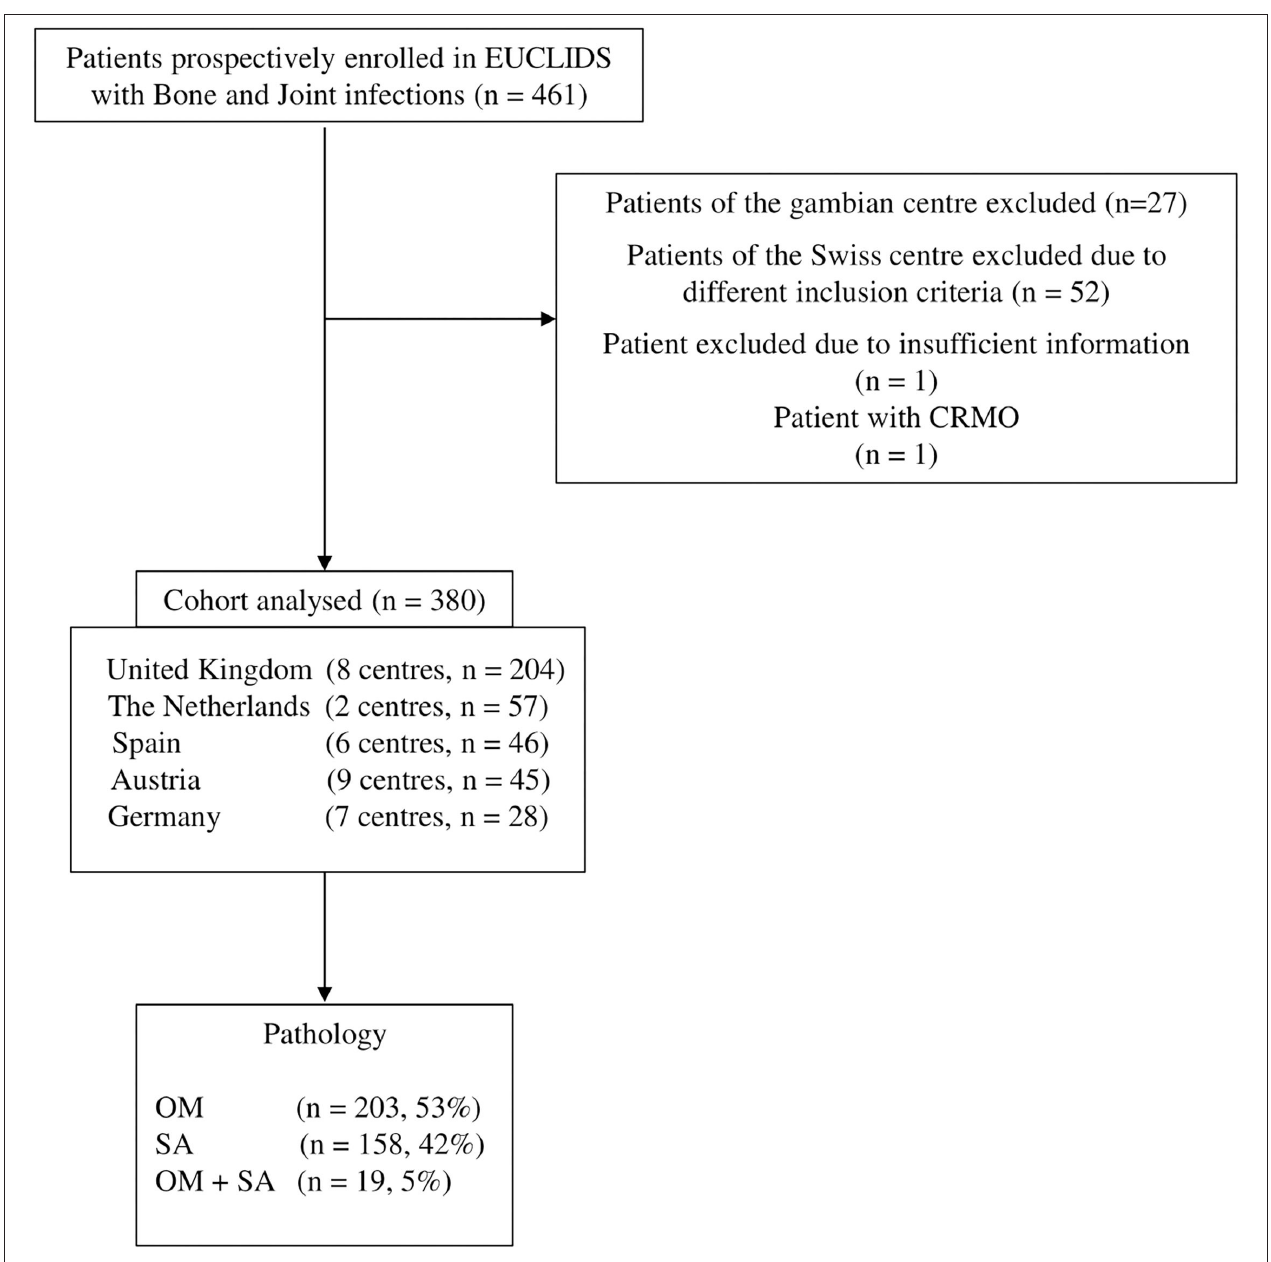
FIGURE 1 | Flow diagram of patients with Bone and Joint infections eligible for this